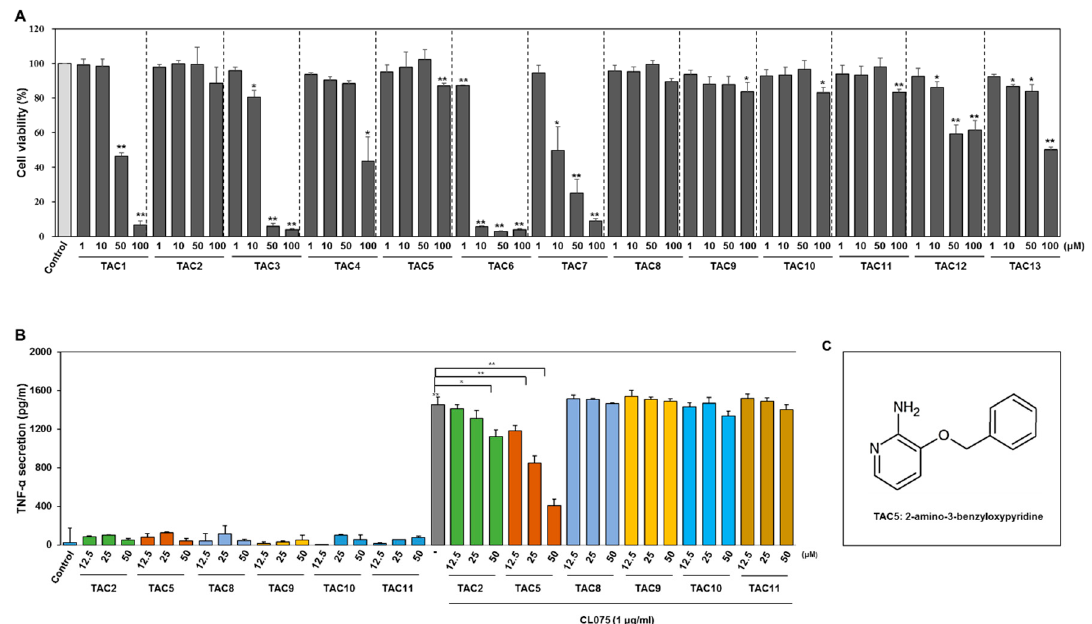
Figure 1. Cell viability measurement and TNF- α -inhibitory profile of TAC5. ( A ) RAW 264.7 cells were treated with selected compounds at di ff erent concentrations (1, 10, 50, or 100 µ M) for 24 h. Cell viability was measured by a 3-(4,5-dimethylthiazol-2-yl)-2,5-diphenyltetrazolium bromide (MTT) assay. The percentage of viable cells as compared to control is presented in a histogram. All experiments were independently conducted three times and mean ± SEM of the independent experiments was calculated by a two-tailed paired Student’s t -test (* p < 0.05, ** p < 0.01). ( B ) RAW 264.7 cells were treated with the compounds TAC2, TAC5, and from TAC8 to TAC11 at concentrations of 12.5, 25, and 50 µ M in the presence and / or absence of CL075 for 24 h. The secreted levels of TNF- α were measured in the cell culture supernatant by a TNF- α enzyme-linked immunosorbent assay (ELISA) kit. ( C ) A two-dimensional representation of the chemical structure of TAC5. All experiments were independently conducted five times and the mean ± SEM of the independent experiments was calculated by a two-tailed paired Student’s t -test (* p < 0.05, ** p <